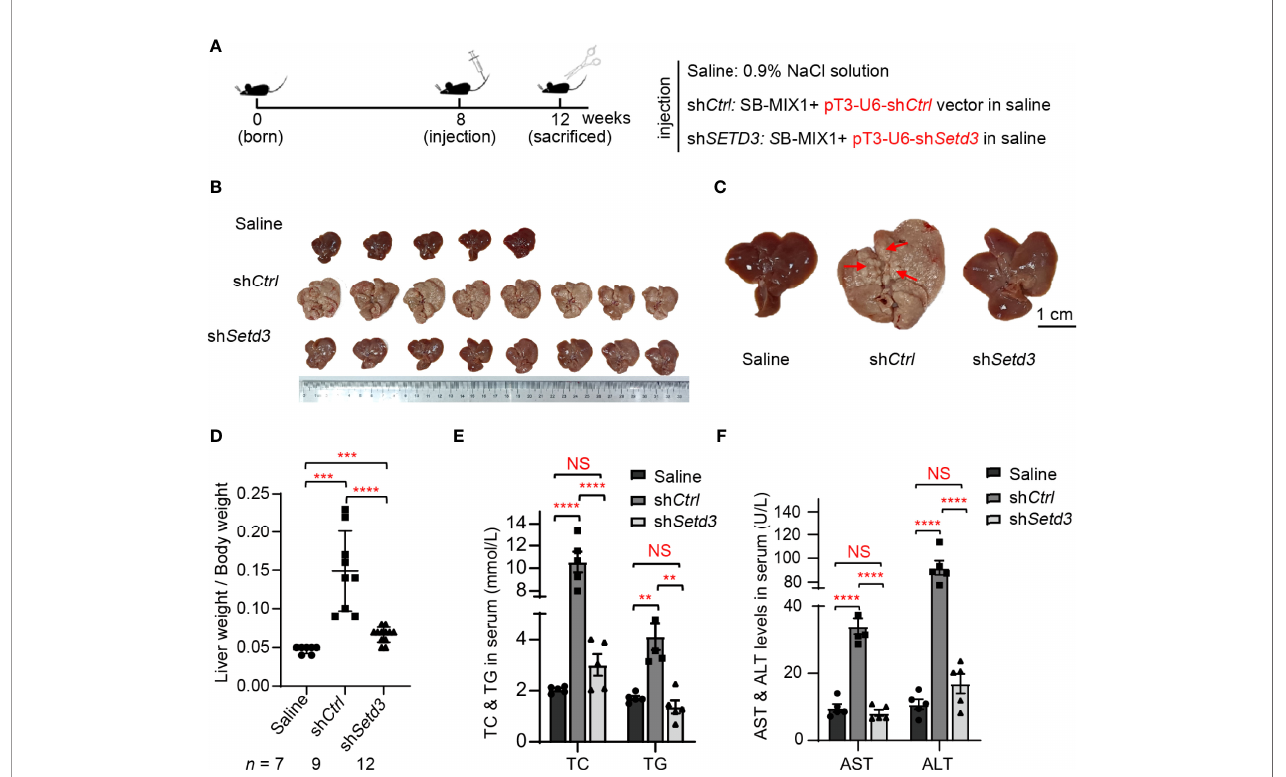
FIGURE 5 | Knockdown of Setd3 rescued myr- AKT - and NRAS -induced hepatic tumorigenesis in mice. (A) Experimental procedure of development of hepatocarcinogenesis in mice by hydrodynamics-based DNA transfection. Each injection represents delivery of different components as indicated on the right. (B) Macroscopic appearance of livers and tumors from mice injected the indicated genes. (C) The representative enlarged images of livers from different mice are shown. The red arrows indicate the positions of liver tumors. Scale bar, 1 cm. (D) Relative ratios of liver weights vs. body weights in each group of hydrodynamic-injected mice ( n =7, 9, or 12 in saline, sh Ctrl , or sh Setd3 , respectively). (E, F) Quanti fi cation of serum TC and TG in panel (E) or serum AST and ALT in panel (F) of the indicated mice ( n = 5, per group). Data are presented as mean ± SD. NS, not signi fi cant; ** p < 0.01; *** p < 0.001; **** p <